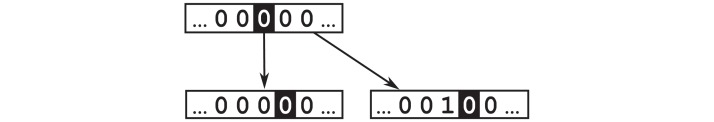
Schematic illustration of the two types of edges in a directed butterfly network.The node (l, z) is shown as the bit string z with a square around the lth bit. “Down” edges increment l, leaving z unchanged, while “down-right” edges increment l and invert the lth bit of z. In the wrap-around variant, the nodes with maximum l have down and down-right edges to the nodes with l = 0.